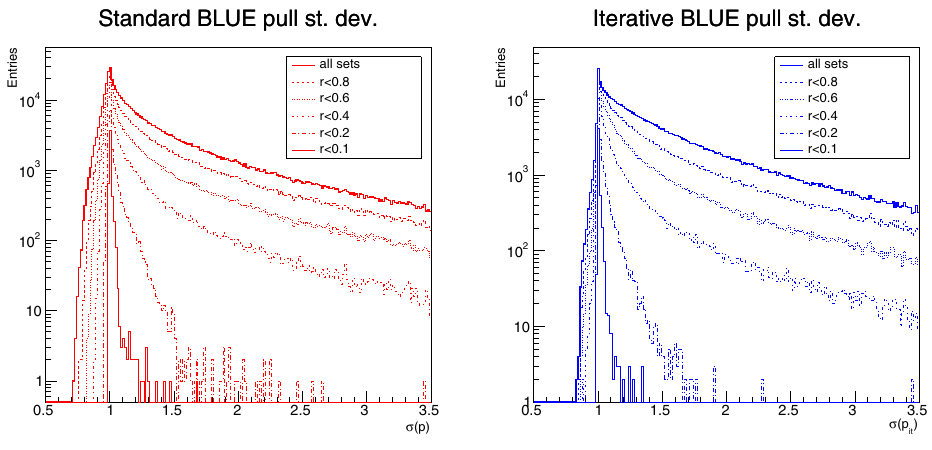
Figure 4. Distribution of the average value of the pull standard deviation for the standard (left) and iterative (right) BLUE estimates for di ff erent limits on r 1 , 2 . The figure is from ref.